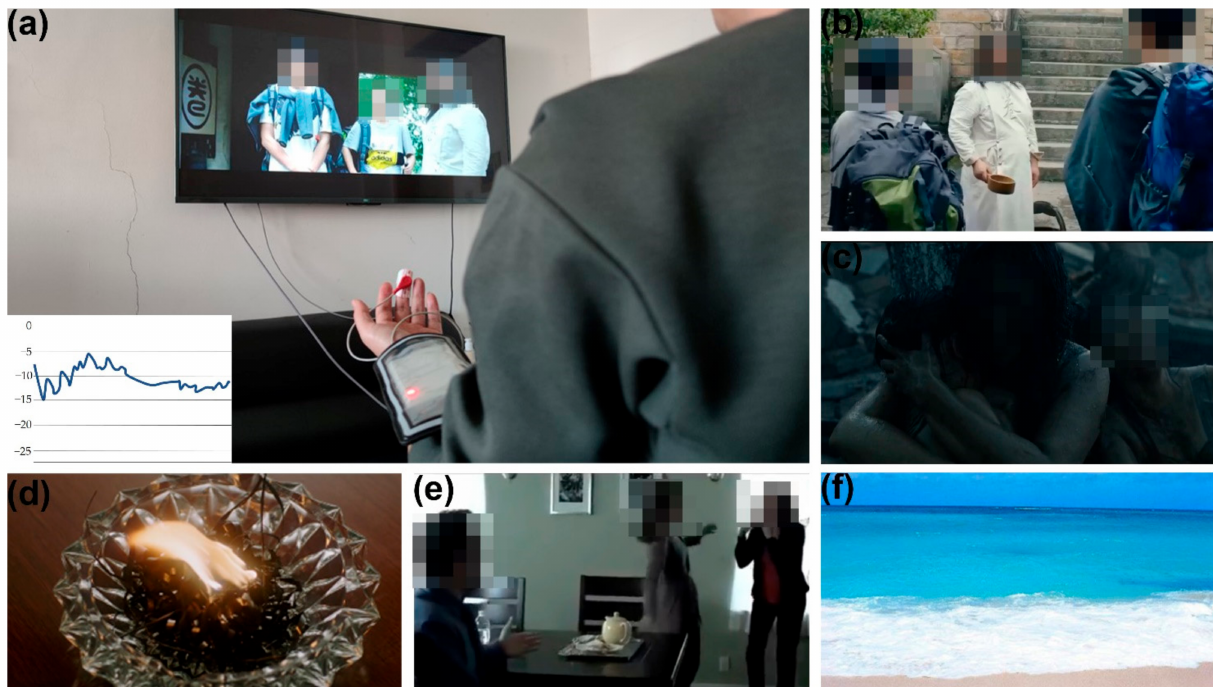
Figure 4. ( a ) The experimental scene and a screenshot of the SP signal on the mobile phone; ( b ) The scene of happiness from the first part of the video (excerpt from the movie NEVER SAY DIE); ( c ) The scene of sadness from the second part of the video (excerpt from the movie Aftershock); ( d ) The scene of anger from the third part of the video (excerpt from the movie God Of Gamblers); ( e ) The scene of fear from the fourth part of the video (excerpt from the movie Insidious); ( f ) The landscape image shown between two adjacent video